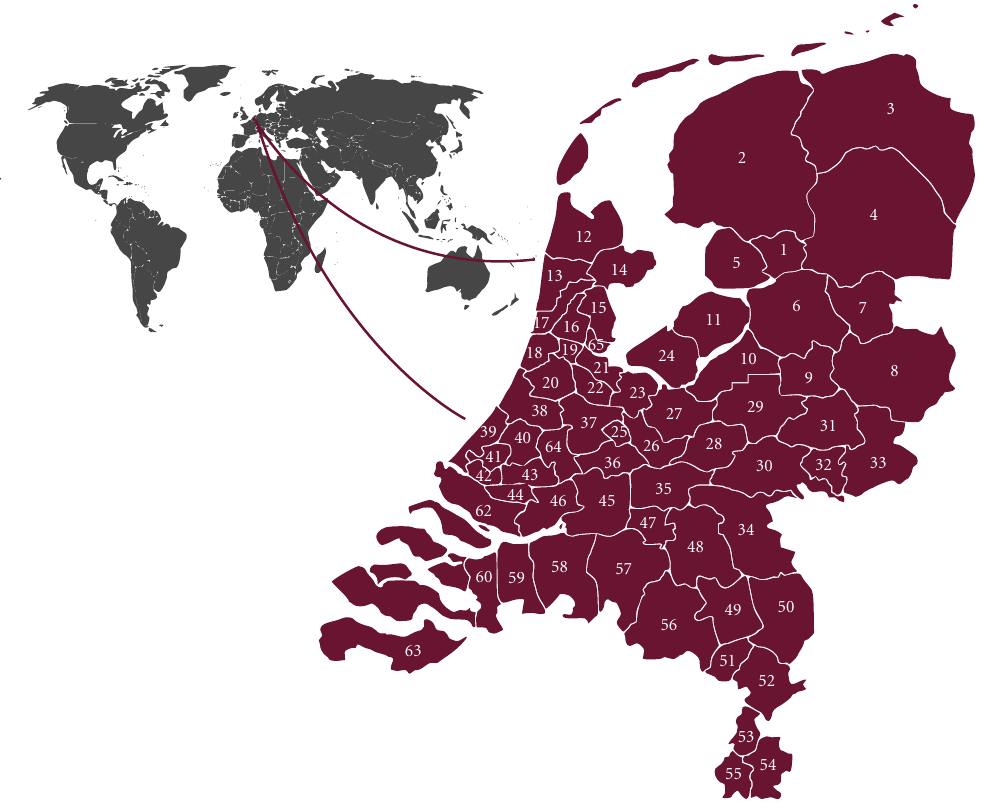
Figure 2: Coverage of ParkinsonNet throughout the